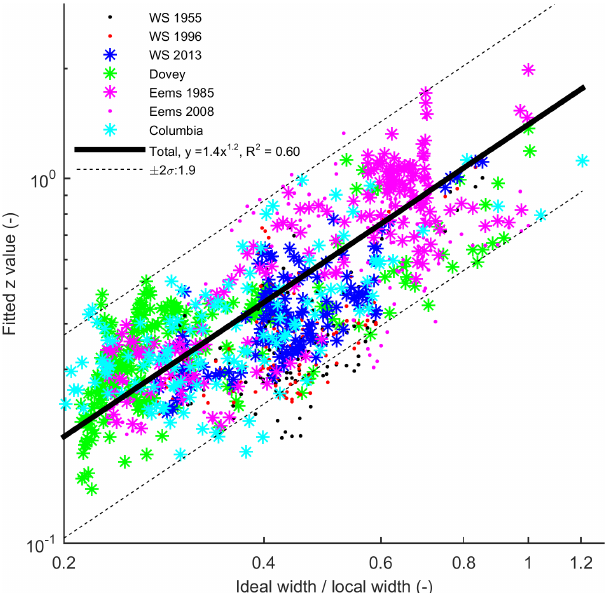
Figure 8. Fitted z values of filtered data increase with the fraction of ideal width and local width, which indicates that hypsometric shapes become progressively more concave when the local width approaches the ideal width and become more convex when the local width becomes larger than the ideal width (i.e. the excess width increases). The data shown as asterisks are used for the regression. Confidence limits are plotted at 2 standard deviations above and below the regression and their multiplication factor compared to the trend is given in the